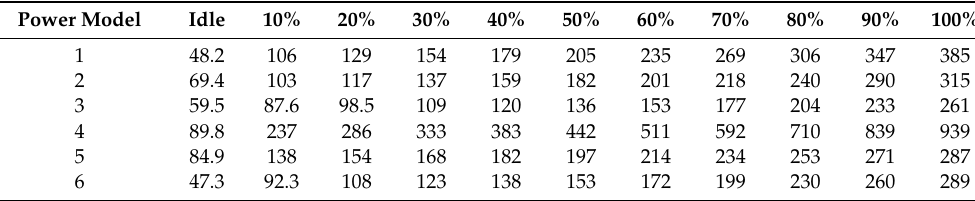
Table 3. Power (in Watts) setting of physical machines (PMs).